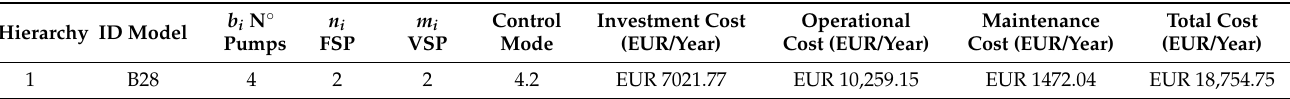
Table 16. Obtained results in (TF-PS1) in the first alternative of conventional design (analyzing life cycle costs). Hierarchy ID Model